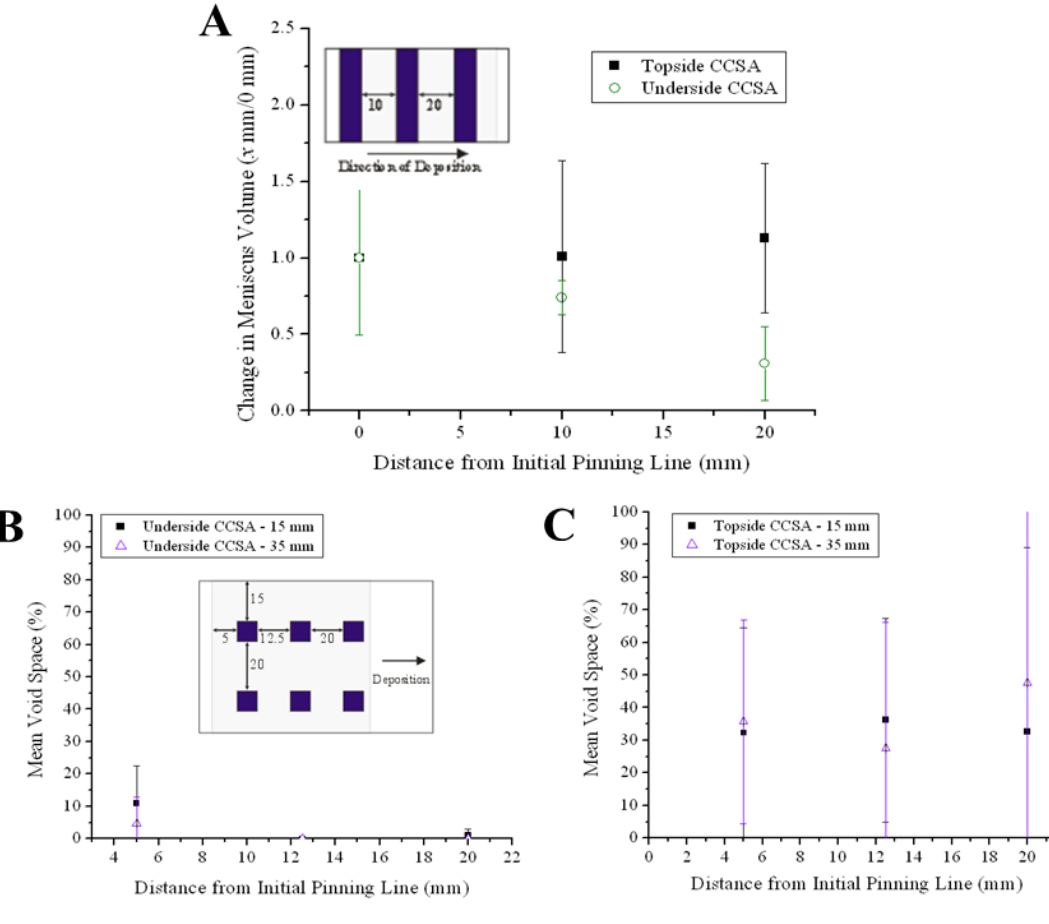
Figure 7. Variation in ( A ) meniscus volume and ( B ) mean void space over coating length during topside and underside CCSA deposition. Insets show sampling scheme for characterizing each parameter; all marked distances are in mm from the beginning of the